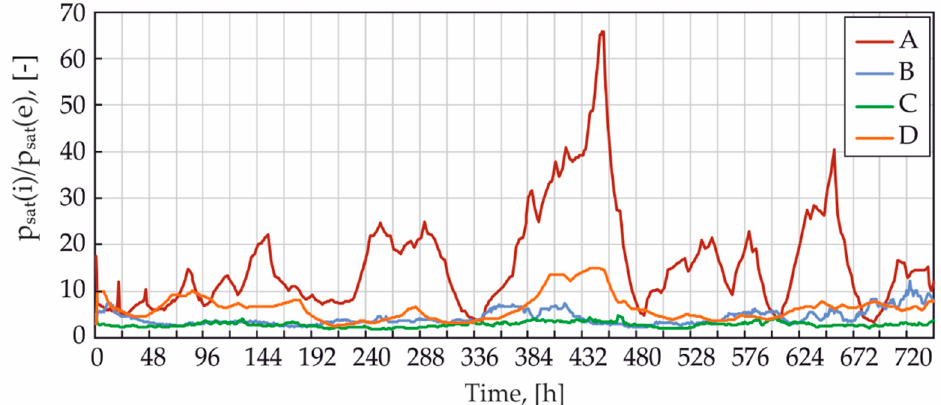
Figure 9. Multiplicity of partial pressure on the internal side ( p sat (i)) in relation to the partial pressure on the external side ( p sat (e)) for January.